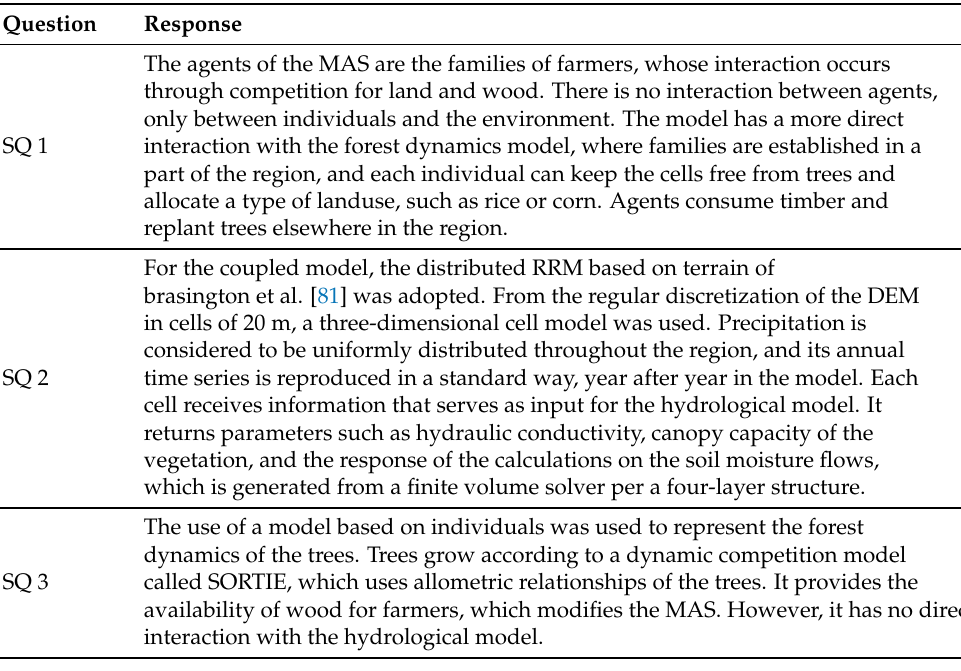
Table A1. Answers of specific questions about the work of Bithell and Brasington